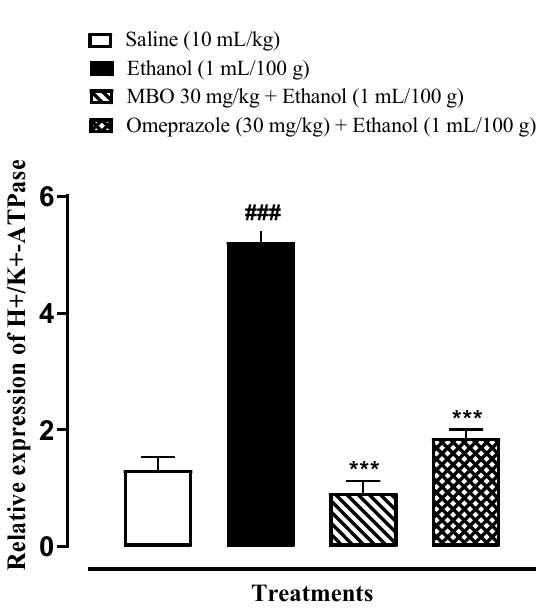
Figure 8. Effects of MBO in H + /K + -ATPase expression in ethanol-induced gastric ulcer model. The mRNA levels of H + /K + -ATPase were measured by RT-PCR using specific primers. Significance at ***